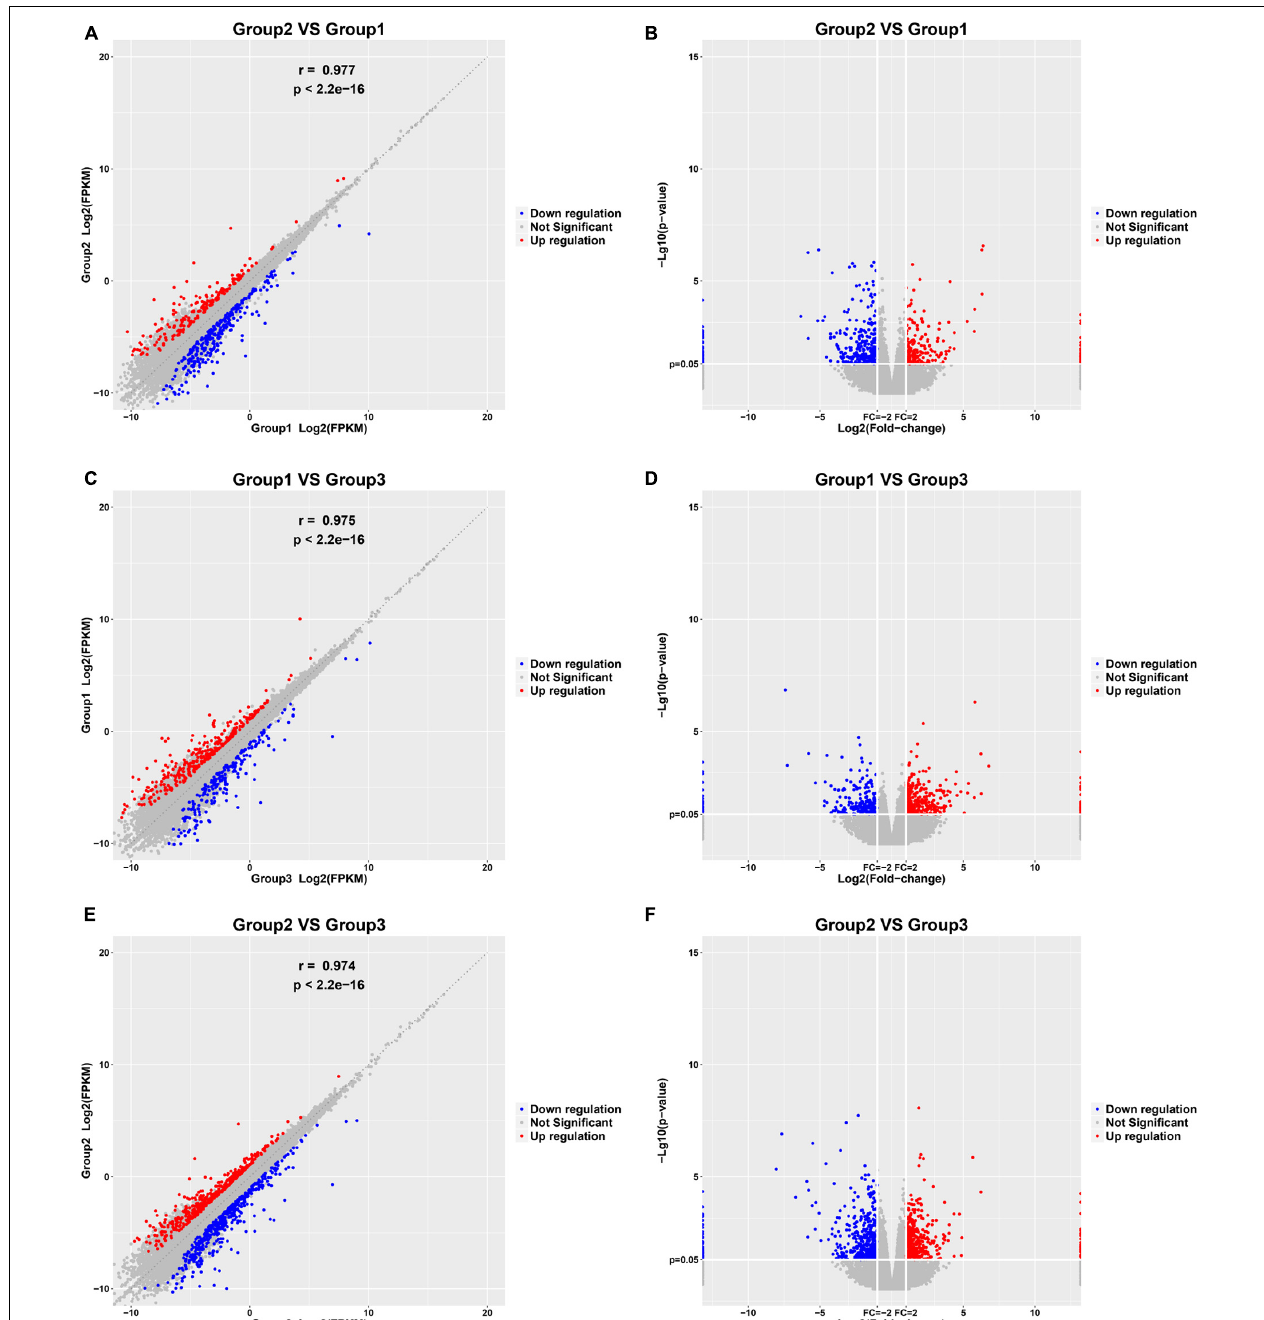
FIGURE 1 | Identification of DEGs among normal, paroxysmal AF and persistent AF samples. (A,B) The scatter plot and volcano plot show the DEGs in paroxysmal AF compared to normal samples. (C,D) The scatter plot and volcano plot show the DEGs in persistent AF compared to normal samples. (E,F) The scatter plot and volcano plot show the DEGs in persistent AF compared to paroxysmal AF